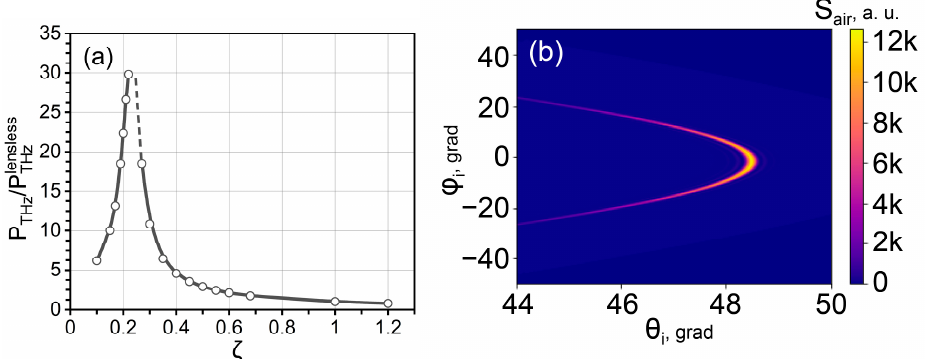
Figure 5. ( a ) The total power ratio P THz / P lensless at 1 THz depending on the Si lens parameter ζ ; ( b ) angular distribution of 1THz power outside the prism-lens coupler calculated for ζ = 0.15.